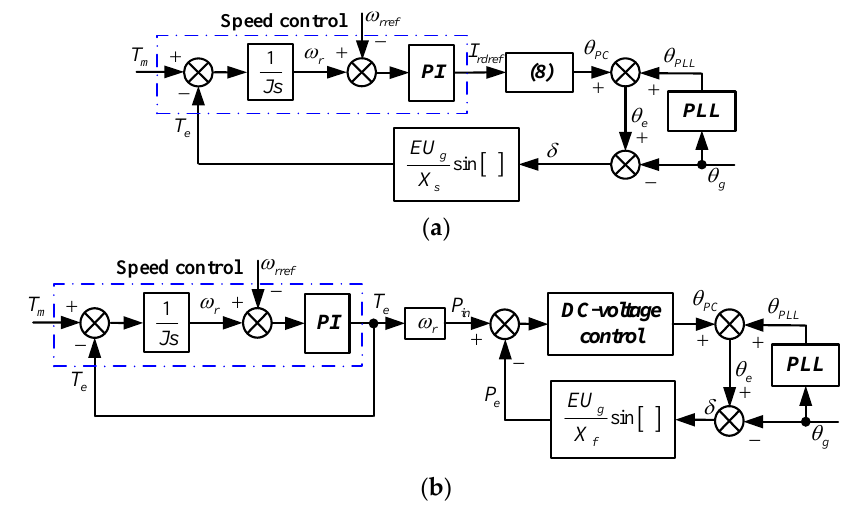
Figure 5. Phase dynamic of defined inner potential of type-3 and type-4 WTs. ( a ) Type-3 WTs; ( b ) Type-4 WTs.